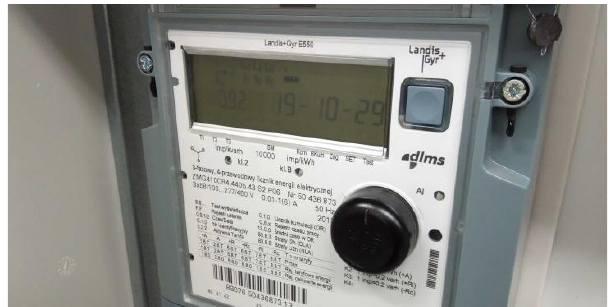
Figure 6. Appearance of the measuring device.